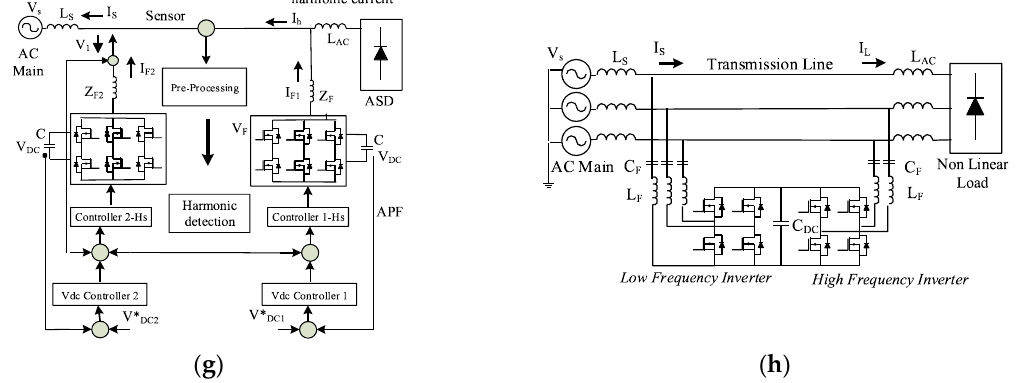
Figure 2. The conventional APFs; ( a ) four-switch three phase shunt APF, ( b ) nine-switch AC/AC converter with a quasi-DC link, ( c ) eight-switch four-leg converter, ( d ) back-to-back two level voltage source converter (VSC), ( e ) three-switch three-capacitor multi-level inverter (MLI), ( f ) six-switch two leg inverter, ( g ) 12-switch APF with feedback harmonic detection, ( h ) eight-switch dual parallel full bridge inverter, Reproduced with permission from [28], Copyright Elsevier, 2017.